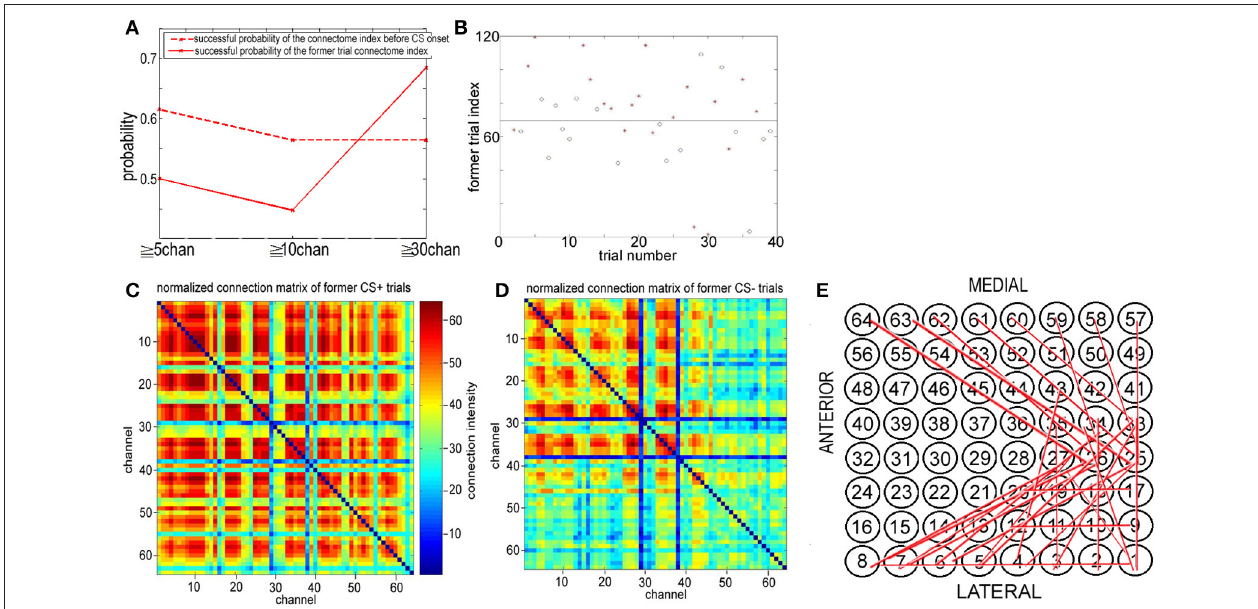
FIGURE 9 | Former trail connectome index. (A) The successful discriminating probability between CS onset and the former trail index of the connectome in the 8–20Hz band from 1.8 to 3s (just before the next CS onset). (B) Former trail index of the connectome in the 8–20Hz band from 1.8 to 3s across more than 30 channels. Former trail CS trail connectome in the 8–20Hz band from 1.8 to 3s across more than 30 channels. There is clearly large scale strong connecting activity after US on set ( p 10 − 88 , α 0.05 t -test). (E) The most significant connections focus on channel 1 to channel 12, corresponding to the lateral area of the visual cortex. × =